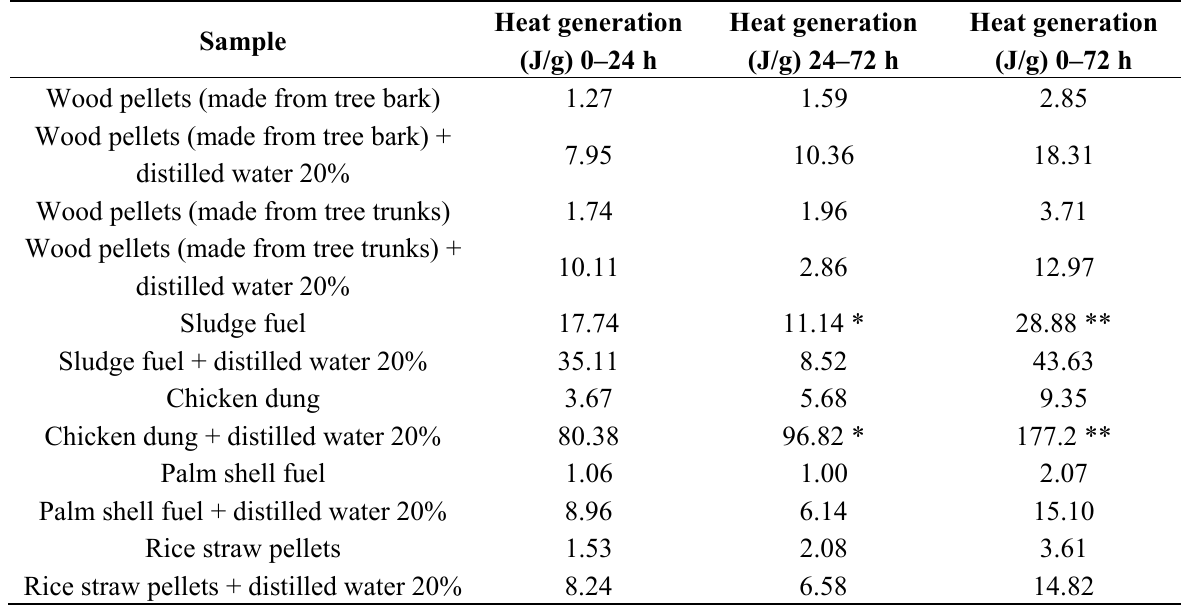
Table 2. Heat generation of various biomass fuels, as determined by TAM calorimetry at 50 °C (untreated samples).